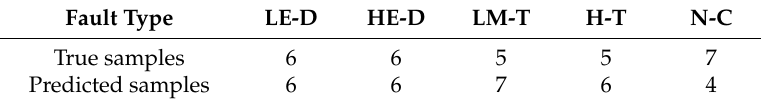
Table 10. Diagnostic results of 30 groups of DGA fault data.